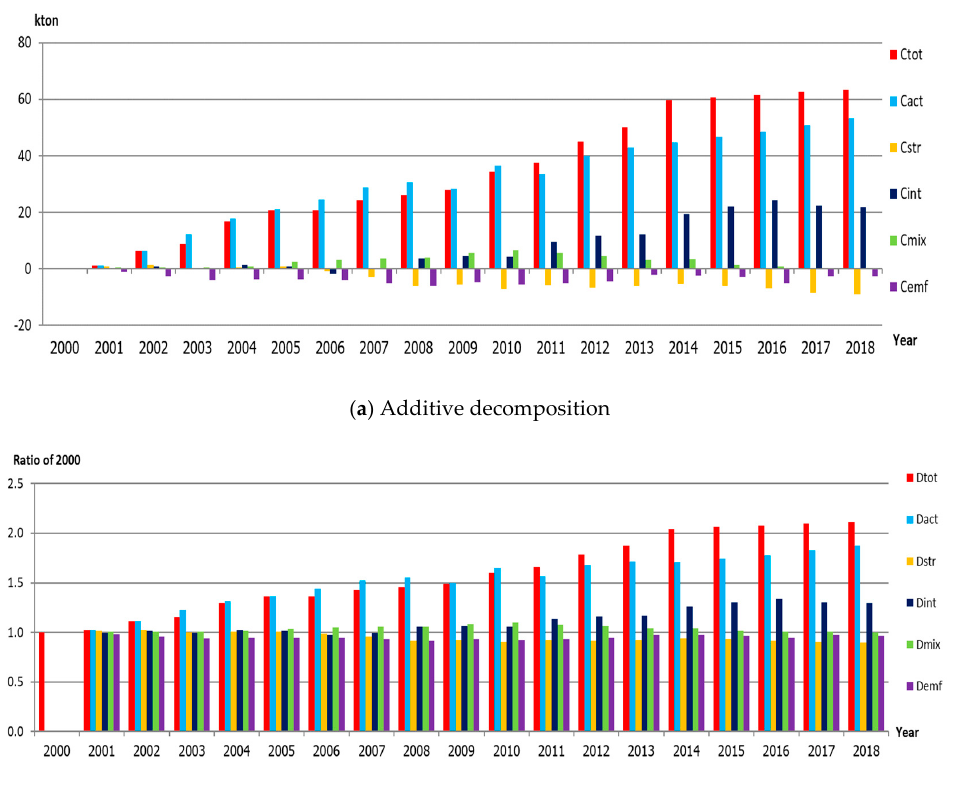
Figure 3. Decomposition of amount of CO 2 emissions of the manufacturing sector, 2000–2018: ( a ) Additive decomposition; ( b ) Multiplicative decomposition.